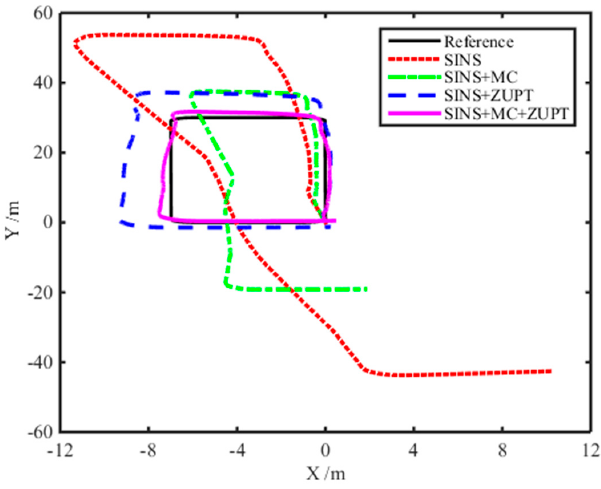
Figure 9. Positioning result of the SINS with different correction methods.